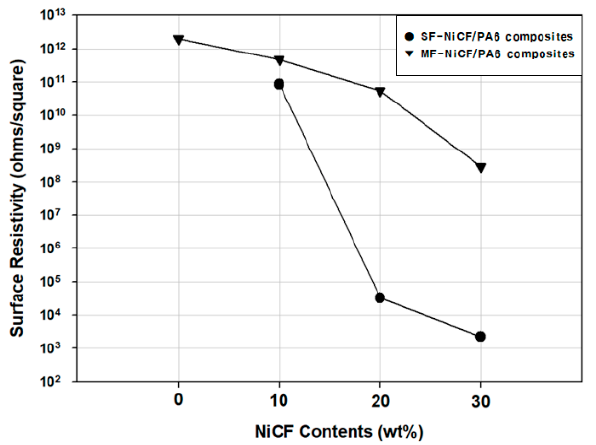
Figure 11. Surface resistivity of the MF-NiCF/PA6 and SF-NiCF/PA6 composites with various NiCF contents.